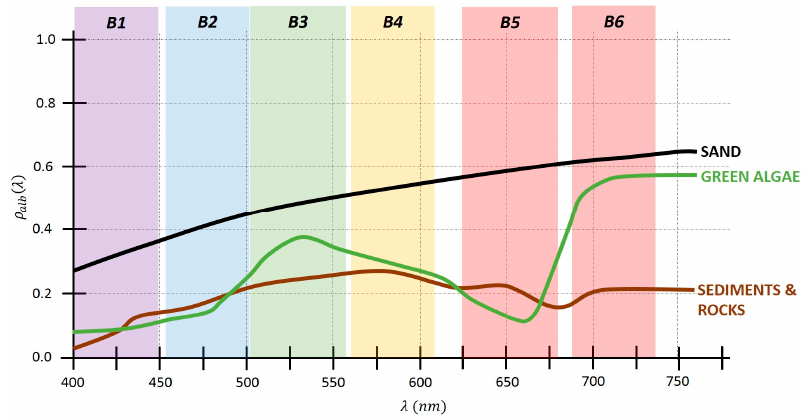
Figure 6. Normalized reflectivity of common pure classes in coastal seabed [50].